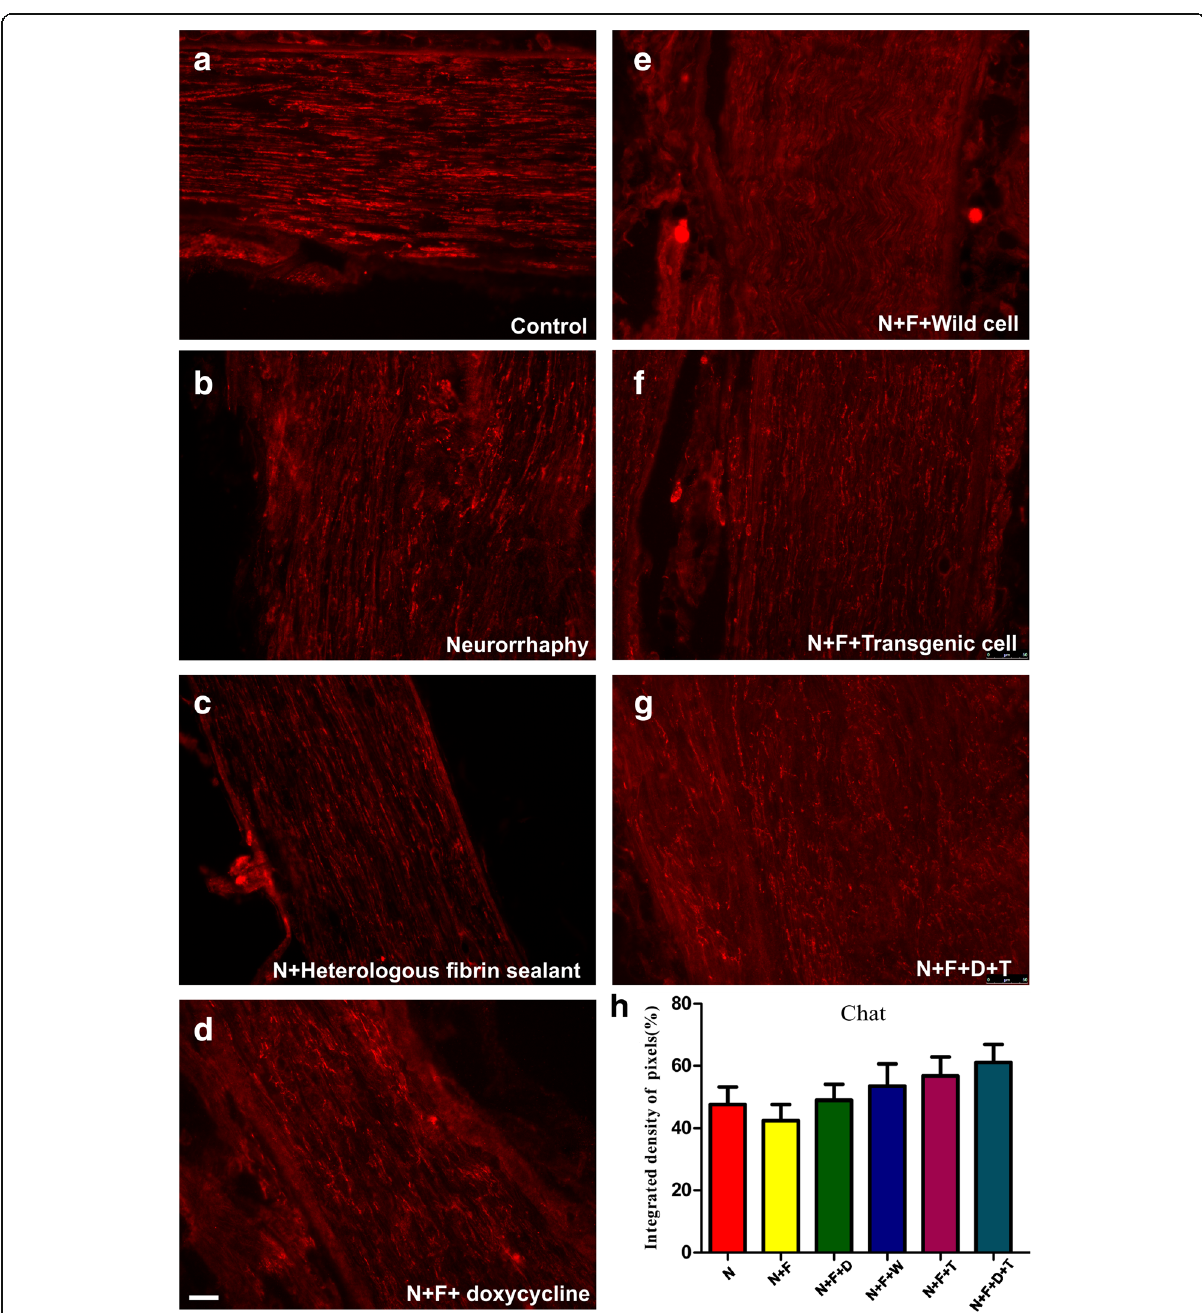
Fig. 4 Anti-ChAT immunostaining of ( a ) the control nerves and ( b to g ) all groups, 60 days after surgery. h Quantification of the integrated density of pixels in the experimental groups in relation to control group (%). Statistically, there is no significant difference among experimental groups. Scale bar: 50 μ m. N: neurorrhaphy, F: heterologous fibrin sealant, D: doxycycline, T: transgenic